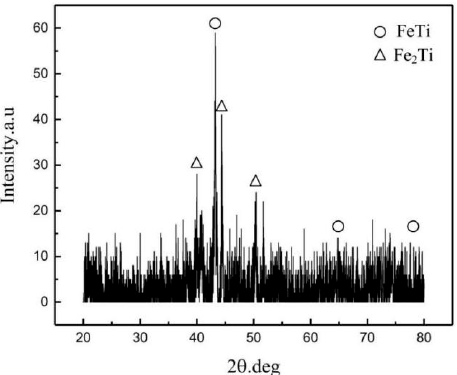
/ TA2 welded joints.